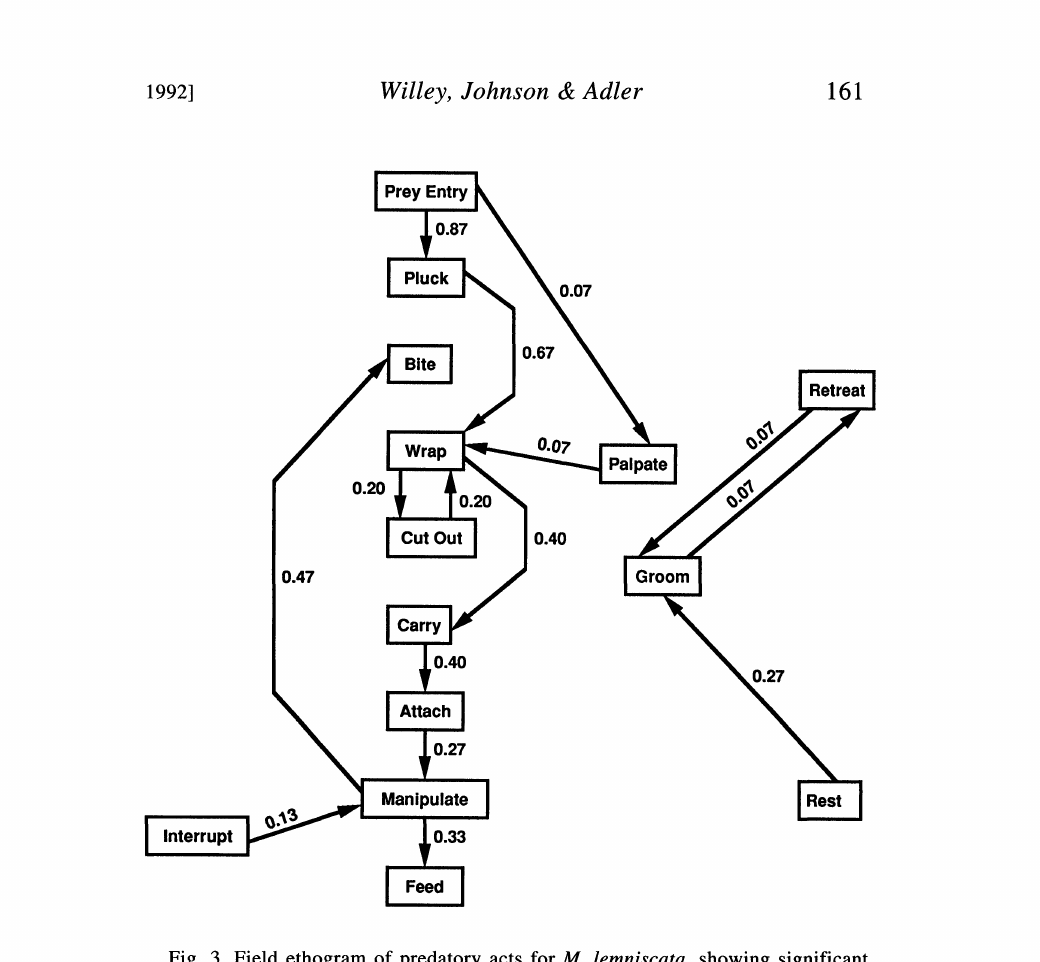
Fig. 3. Field ethogram of predatory acts for M. lemniscata, showing significant behavioral transitions (P < 0.05) when presented with carpenter ants. Values indi- cate the frequency of 15 spiders showing a specific